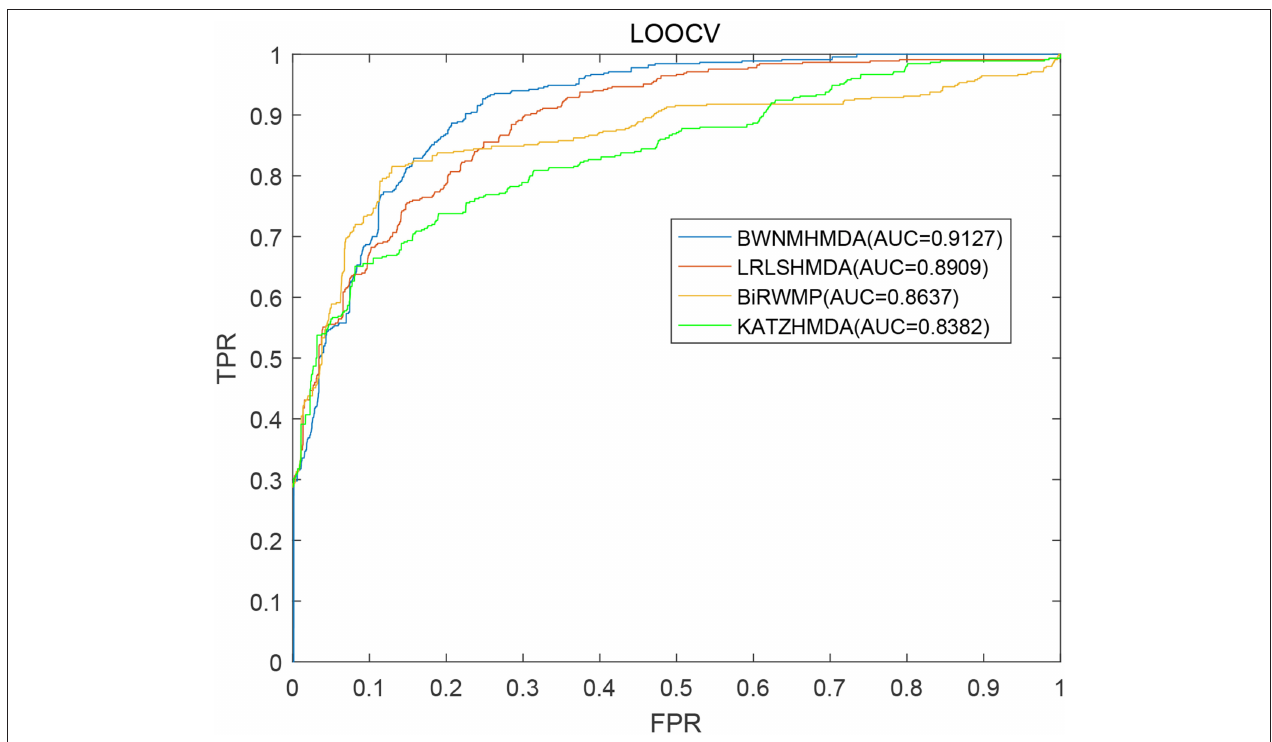
FIGURE 4 | AUCs achieved by KATZHMDA, BiRWMP, LRLSHMDA, and BWNMHMDA in LOOCV.